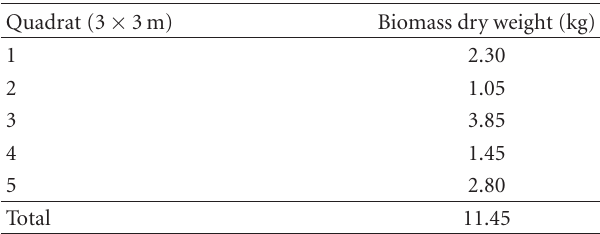
Table 4: Biomass dry weight of aboveground vegetation removed at plot S from five replications of 9m 2